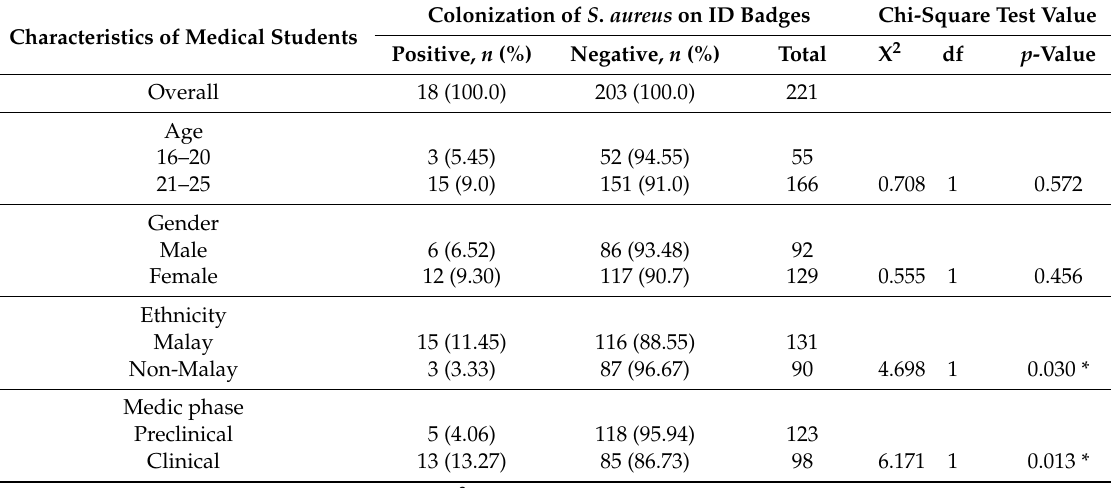
Table 4. Association of the socio-demographic characteristics of medical students with the colonization of S. aureus colonies on ID badges.